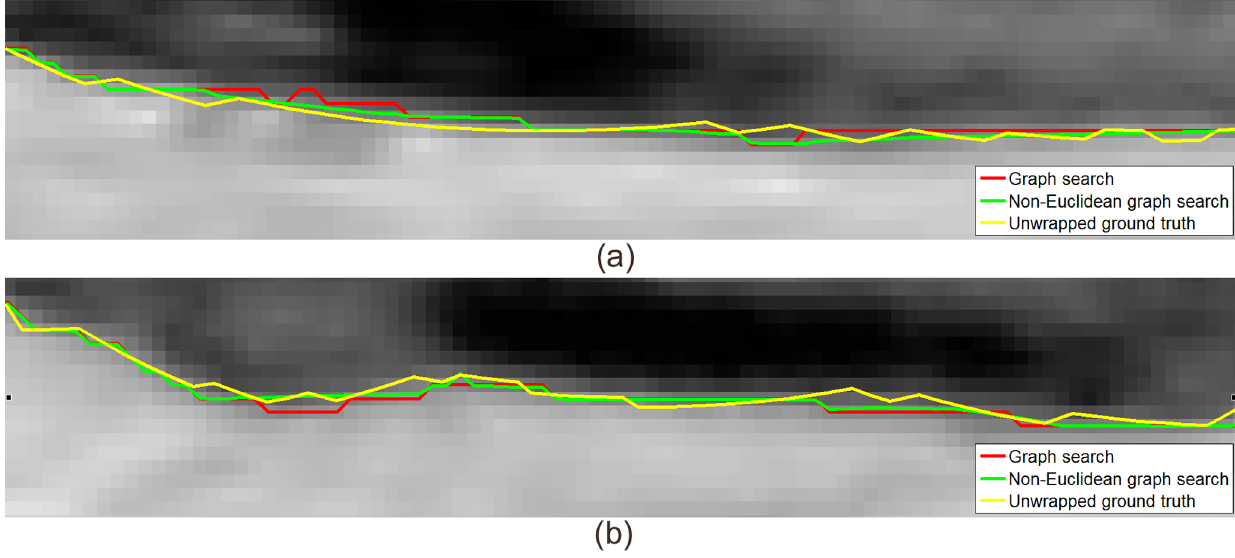
Figure 17. Zoomed in view of vascular wall segmentation results in the unwrapped slice. (a) the left region marked as a cyan rectangle in Fig. 16 (c); (b) the right region marked as a cyan rectangle in Fig. 16 (c).